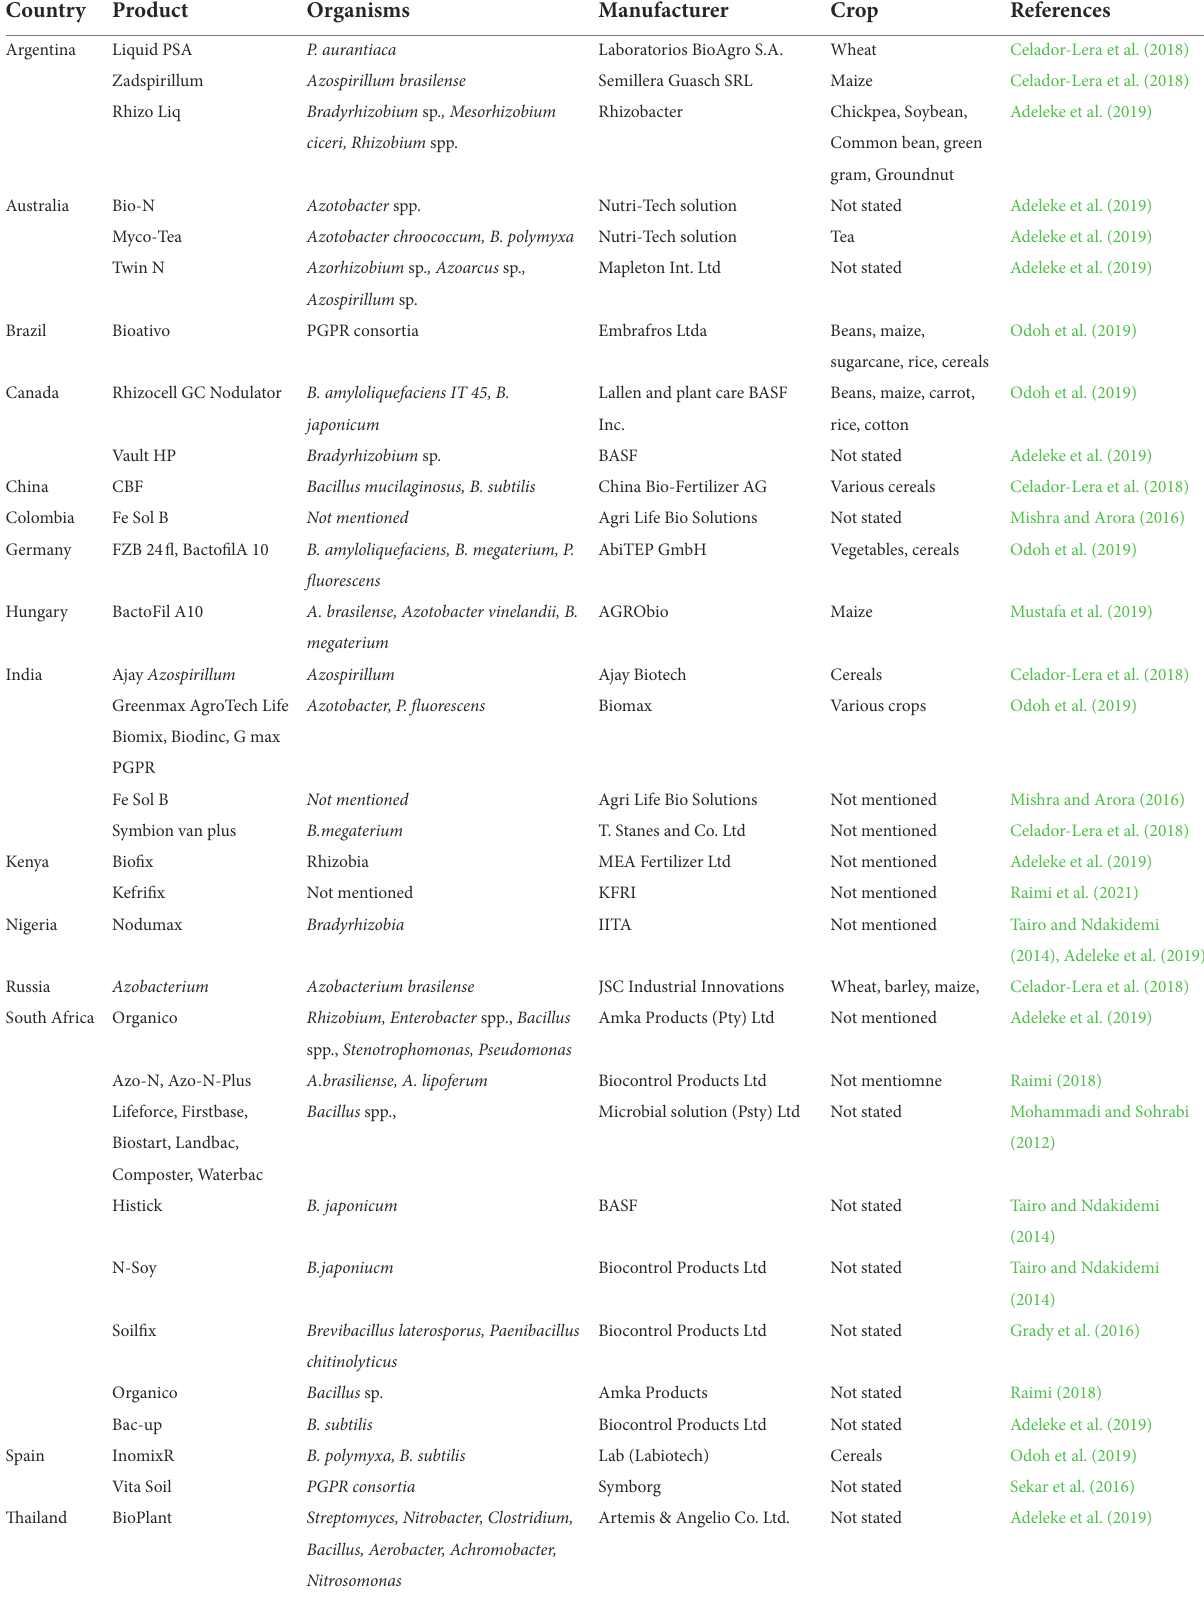
TABLE 2 Examples of commercial biofertilizer products in some countries around the world.